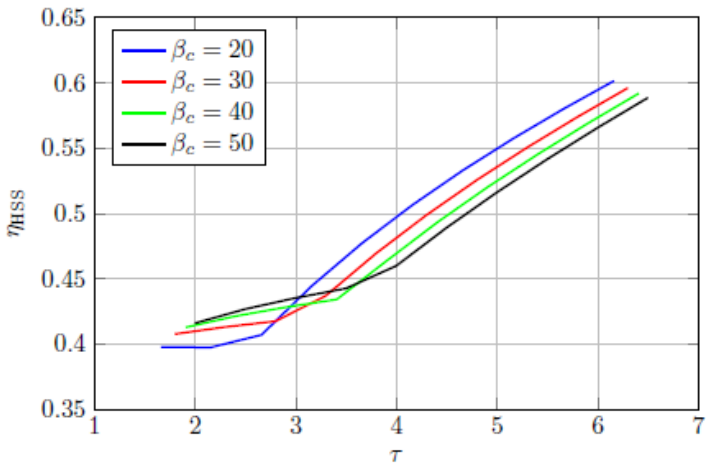
Figure 4. Efficiency of the regenerated HSS system as a function of τ for different values of β c . The plot refers to a system with ξ = 0.5, β e = 0.9 * β c , = 0.80, η t = 0.9, η c = 0.9, and η cc = 0.98. Energies 2017 , 10 , 2035 10 of 15